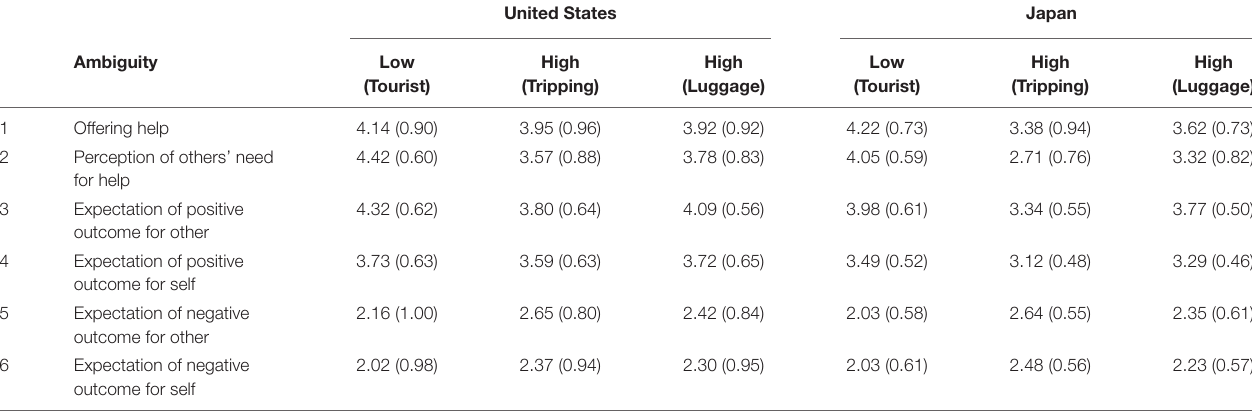
TABLE 2 | Means and standard deviations of main variables among American ( n = 397) and Japanese participants ( n = 399) in Study 3.